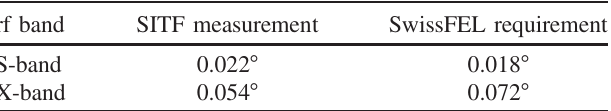
TABLE XII. Equivalent resolution in rf phase achieved by the CDR based electron bunch length monitors at the SITF, in comparison with the resolution goals for SwissFEL.